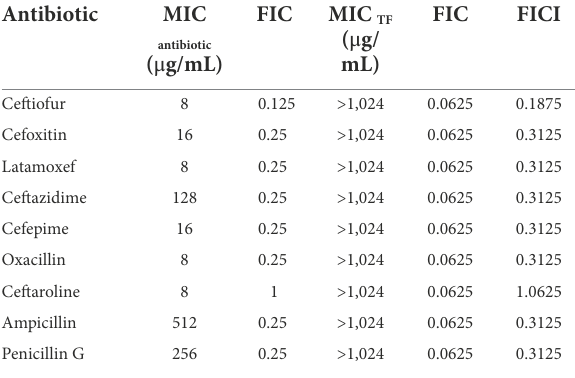
TABLE 2 Antibacterial effect of TF combined with β -lactam antibiotics against S. aureus. Antibiotic